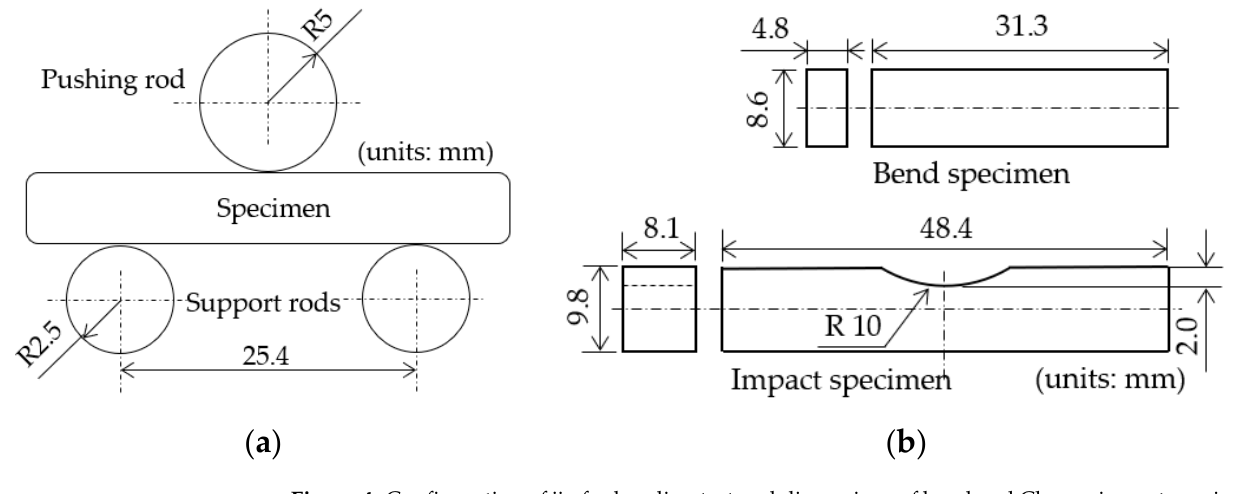
Figure 4. Configuration of jig for bending test and dimensions of bend and Charpy impact specimens. ( a ) Schematic of jig; ( b ) dimensions of specimens.